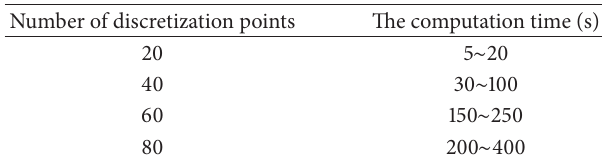
Table 2: Example of computation time for optimizing a reentry trajectory of 25 min flight time using GPM.